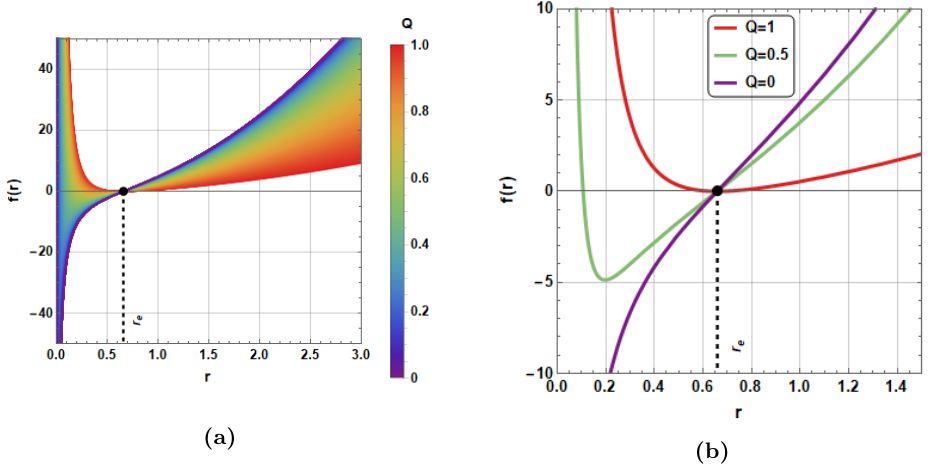
Figure 12. Evolution of f ( r ) function during an isentropic absorption of 500 particles with a fixed electric charge dQ = − 0 . 002 . The initial conditions are Q = 1 , l = 1 , M = 1 . 23 , r h = 0 . 65 and D = 4